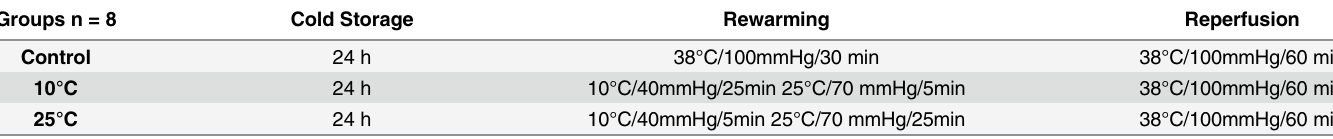
Table 1. This table illustrates the details of study design including duration of cold storage, perfusion temperature, perfusion pressure, rewarming and reperfusion phase. Groups n =